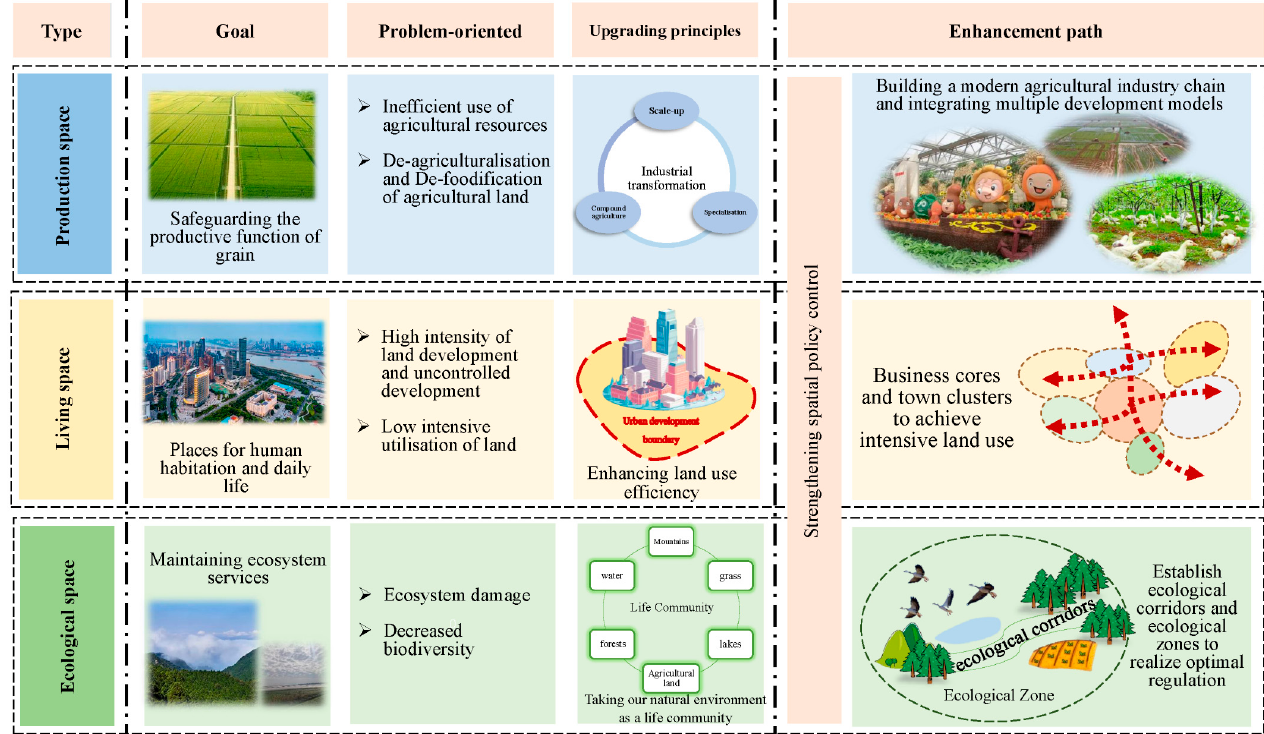
Figure 11. The optimization of territorial space pattern enhancement.